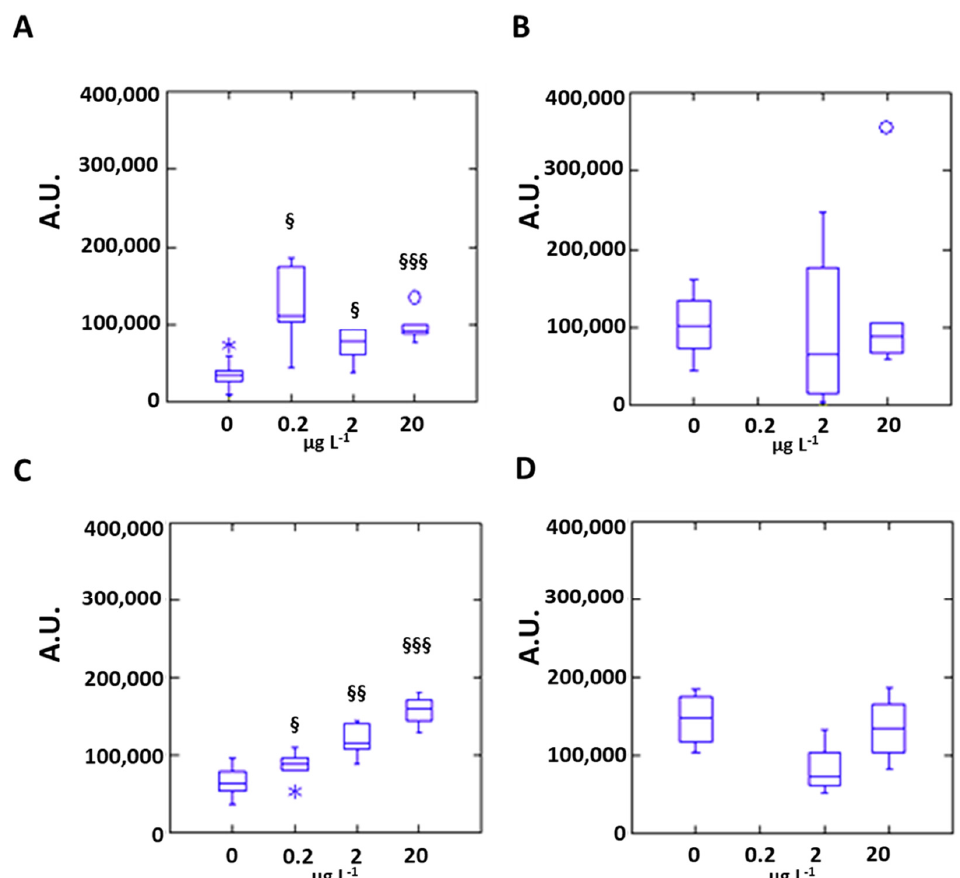
Figure 6. Effects of silver on SOD activity. Semiquantitative analysis of enzyme activity as evaluated by densitometric analysis of achromatic bands in the gel assay (boxplot). Data (arbitrary units) are only comparable within each individual panel. Values between the inner and outer fences are plotted with asterisks. Values beyond the outer fences, called far outside values, are plotted with empty circles. ( A ) Digestive gland, silver nitrate exposure; ( B ) digestive gland, silver nanoparticle exposure; ( C ) gills, silver nitrate exposure; ( D ) gills, silver nanoparticle exposure. §§§ statistically different from control reference (0), p < 0.001; §§ , p < 0.01; § p < 0.05; two-sample Kruskal–Wallis, n = 40. Data for 0.2 μ g L − 1 silver nanoparticles were not available. In the case of GPX, the total glutathione-dependent peroxidase activity increased for the effects of silver nitrate, but only in gills at the highest concentration tested (20 μ g L − 1 ) (Figure 7).